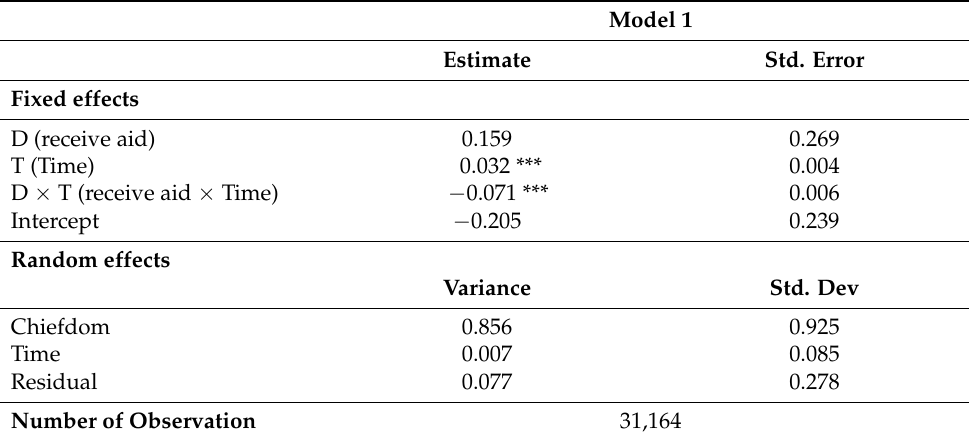
Table 2. Causal effect of agricultural aid on